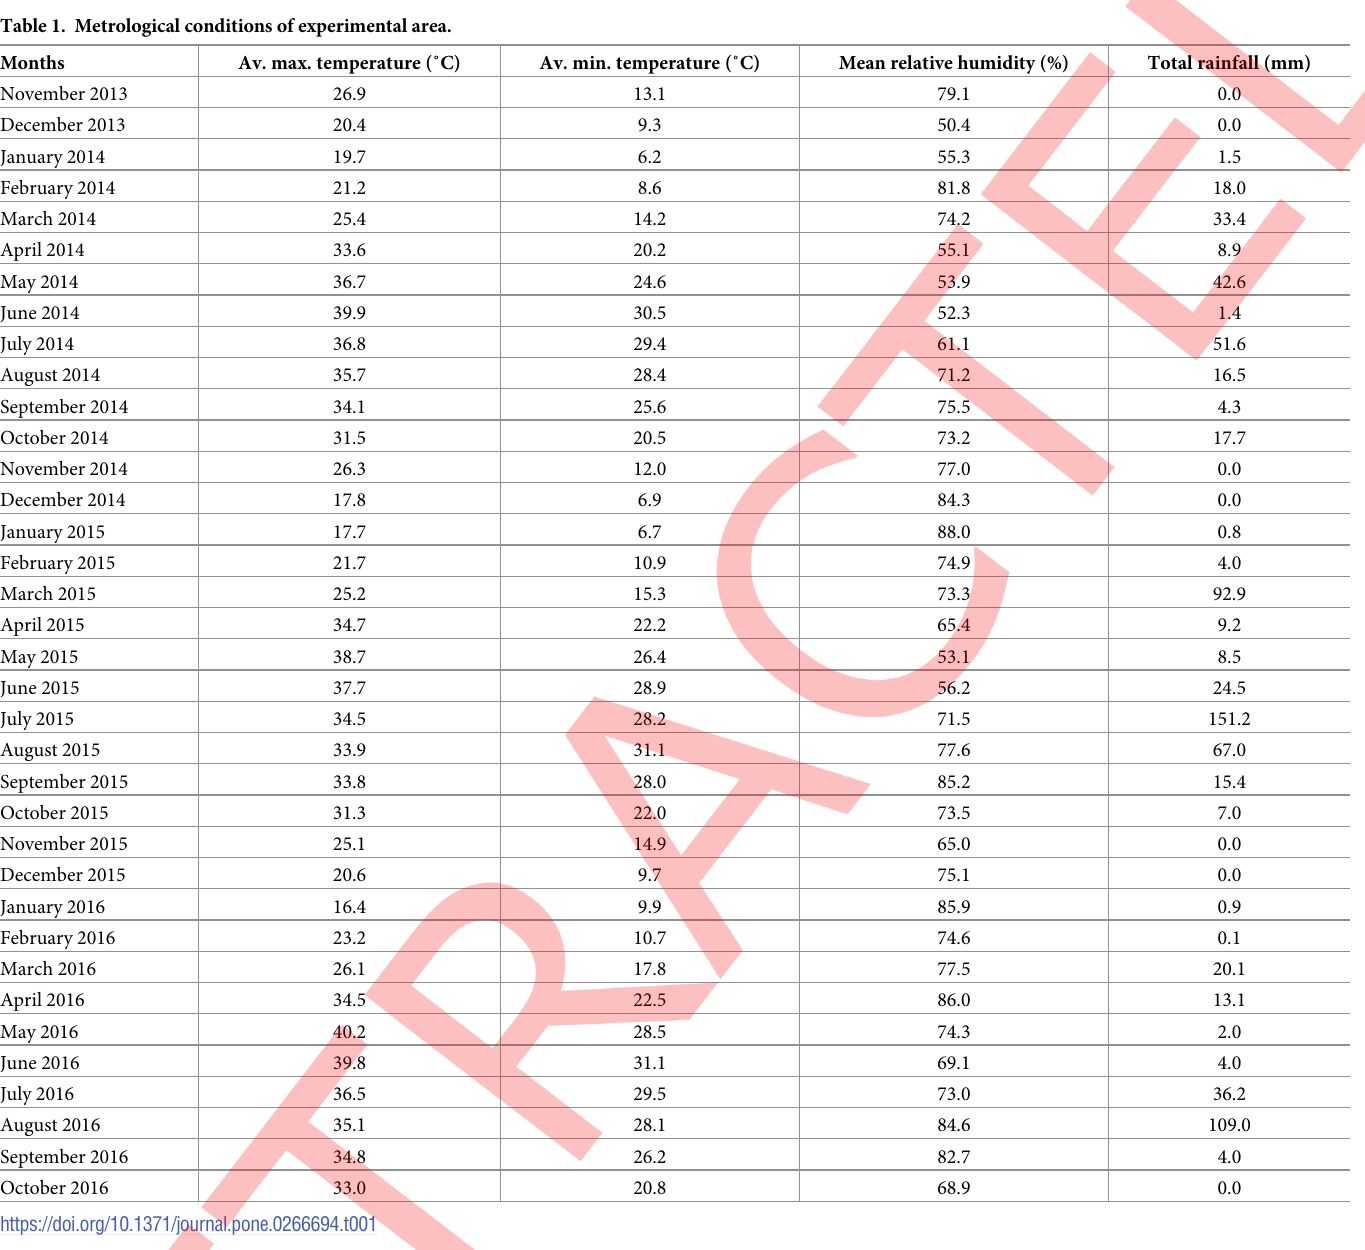
Table 1. Metrological conditions of experimental